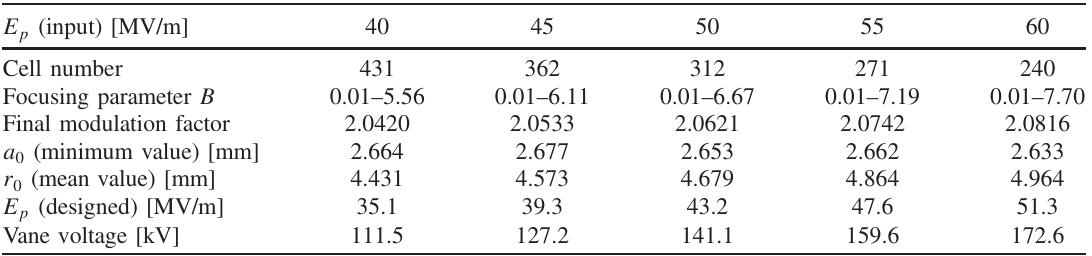
TABLE VI. Cell parameters designed using RFQGen software with SC-RFQ for 2.5 MeV proton beam acceleration.